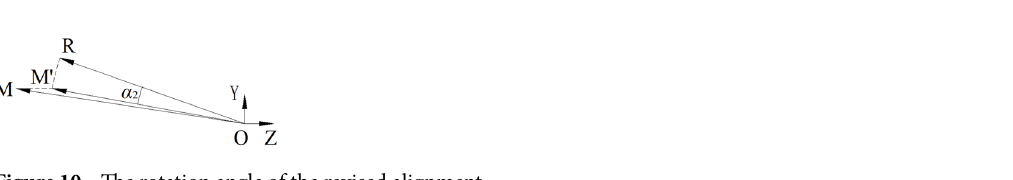
Figure 10. The rotation angle of the revised